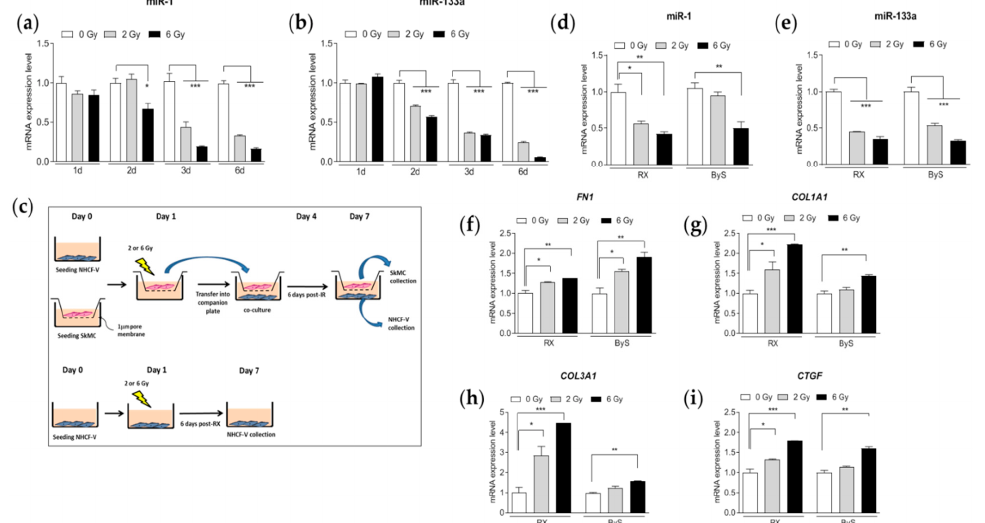
Figure 8. Intracellular levels of miR-1 ( a ) and miR-133a ( b ) in SkMCs after irradiation with 2 and 6 Gy, at different time points post-irradiation. ( c ) Schematic representation of the co-culture system. Intracellular levels of miR-1 ( d ) and miR-133a ( e ) in bystander and irradiated NHCF-Vs. Evaluation of fibronectin 1 ( FN1 ( f )), collagen 1A ( COL1A1 ( g )), collagen 3A1 ( COL3A1 ( h )) and connective tissue growth factor ( CTGF ( i )) expression levels in bystander and irradiated NHCF-Vs. Each dataset represents the mean ± SEM of three independent biological replicates. Values obtained with sham-irradiated cells (0 Gy) were taken as 1. * p < 0.05; ** p < 0.01; *** p < 0.001; (Student’s t -test). RX = irradiated cells. ByS = bystander cells.